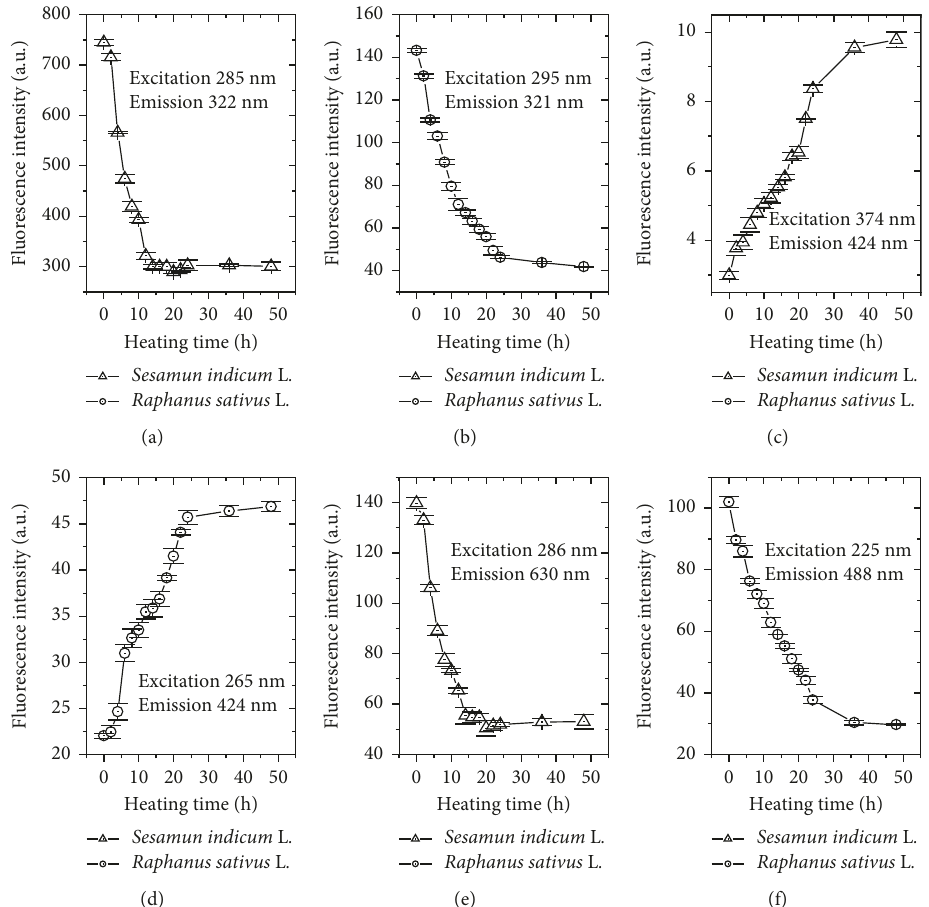
Figure 6: Fluorescence intensities of biodiesels from S. indicum L. and R. sativus L. during the thermal degradation process at specific wavelengths: (a) emission at ∼ 322 and (b) emission at 321nm; (c, d) emission at 424nm; (e) emission at 630nm; (f) emission at 488nm. Error bars represent standard